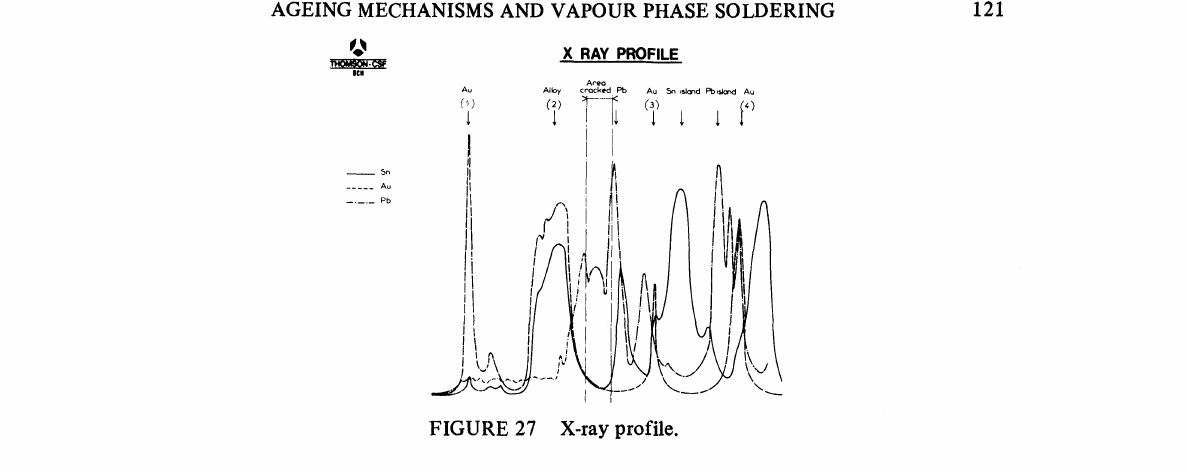
FIGURE 27 X-ray